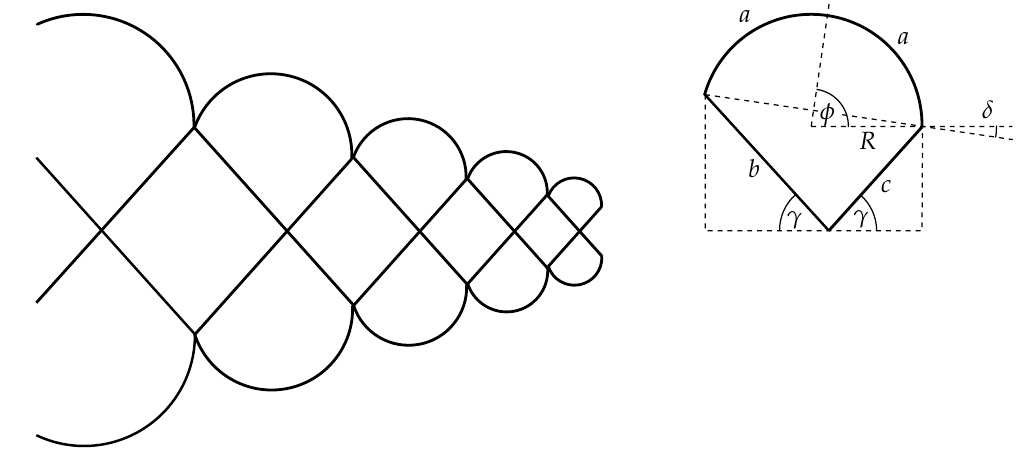
Figure 12. Tapered mattress and geometric relations of an individual